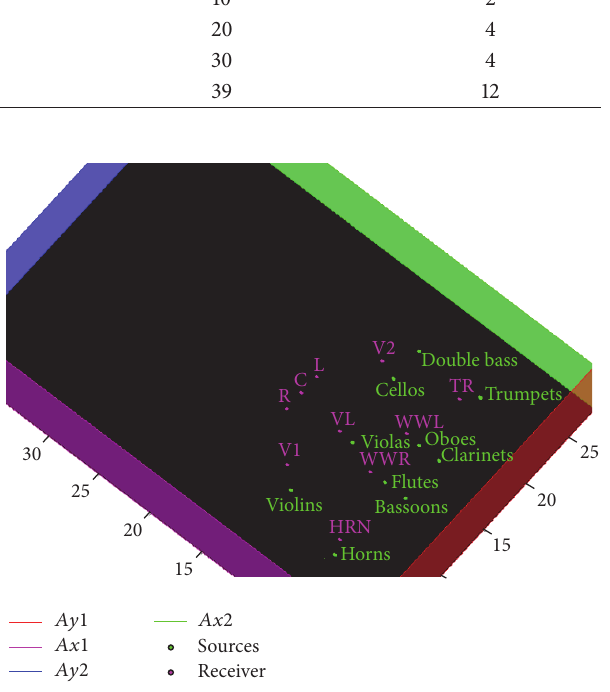
Figure 4: The sources and the receivers (microphones in the simulated